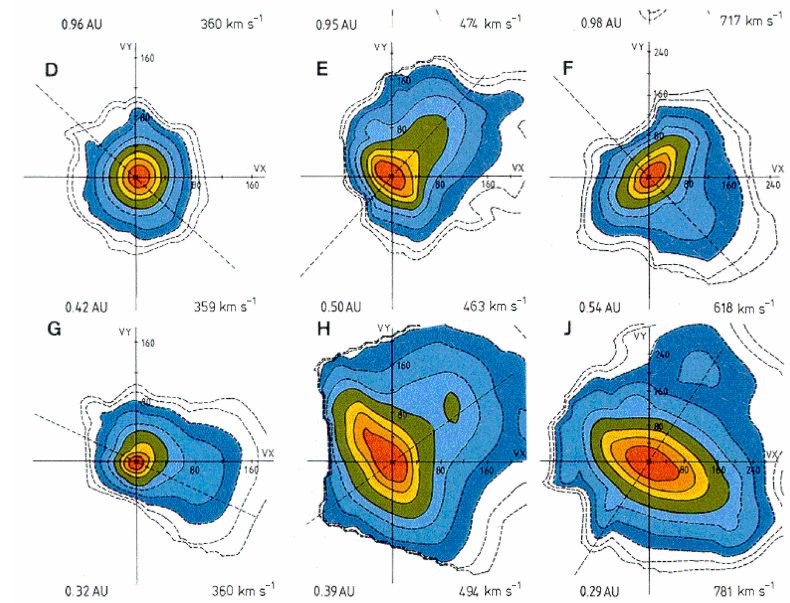
Figure 10. Proton velocity distributions (VDFs) in the solar wind near Helios’ perihelion and farther out after Marsch et al. (1982a). The √ colored isocontours are spaced at a factor of 10, with unity referring to the maximum of the distribution. The VDFs come in a variety of shapes ranging from isotropy to being anisotropic in perpendicular temperature and showing a field-aligned beam or tail. The plots are cuts through the VDFs in the ecliptic plane, with the dashed line giving the magnetic field